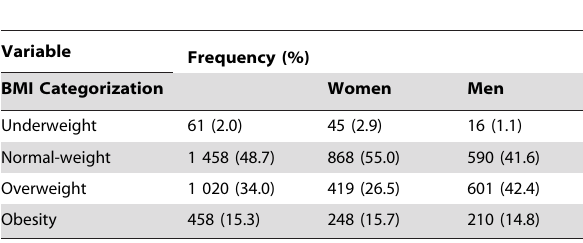
Table 2. Body Mass Index (BMI) categories in the final